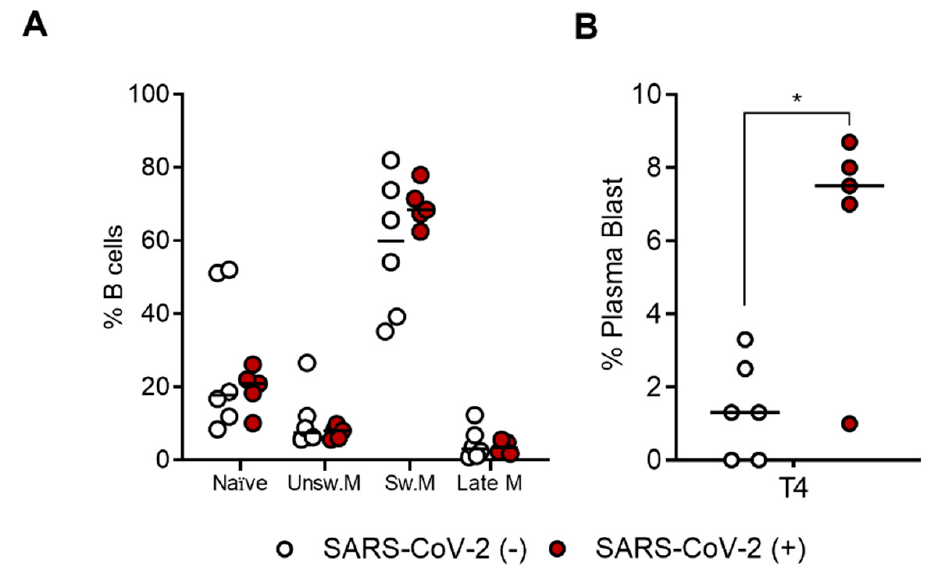
Figure 5. Comparison of SARS-CoV-2-specific B-cell subpopulations between recovered SARS-CoV-2 (+) (n = 5) and uninfected SARS-CoV-2 ( − ) (n = 6) vaccinated subjects at T4. ( A ) Percentage (%) of each SARS-CoV-2-specific B-cell subpopulations (naïve, IgD + CD27 − ; unswitched memory, IgD + CD27 + ; switched memory, IgD − CD27 + ; and late memory, IgD − CD27 − ) at T4 in both uninfected (white dots) and recovered subjects (red dots). ( B ) Percentage (%) of plasma blast (CD27 high CD38 high ) in both uninfected SARS-CoV-2 ( − ) and recovered SARS-CoV-2 (+) subjects at T4. Significance was determined using the Mann–Whitney test and t -tests, * p < 0.0332.